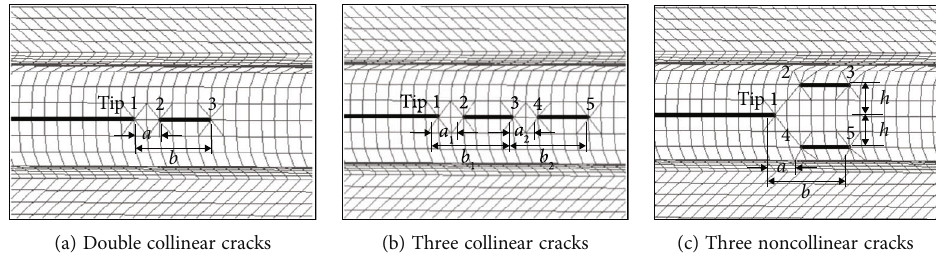
Figure 4: The slot crack groups of the SRM